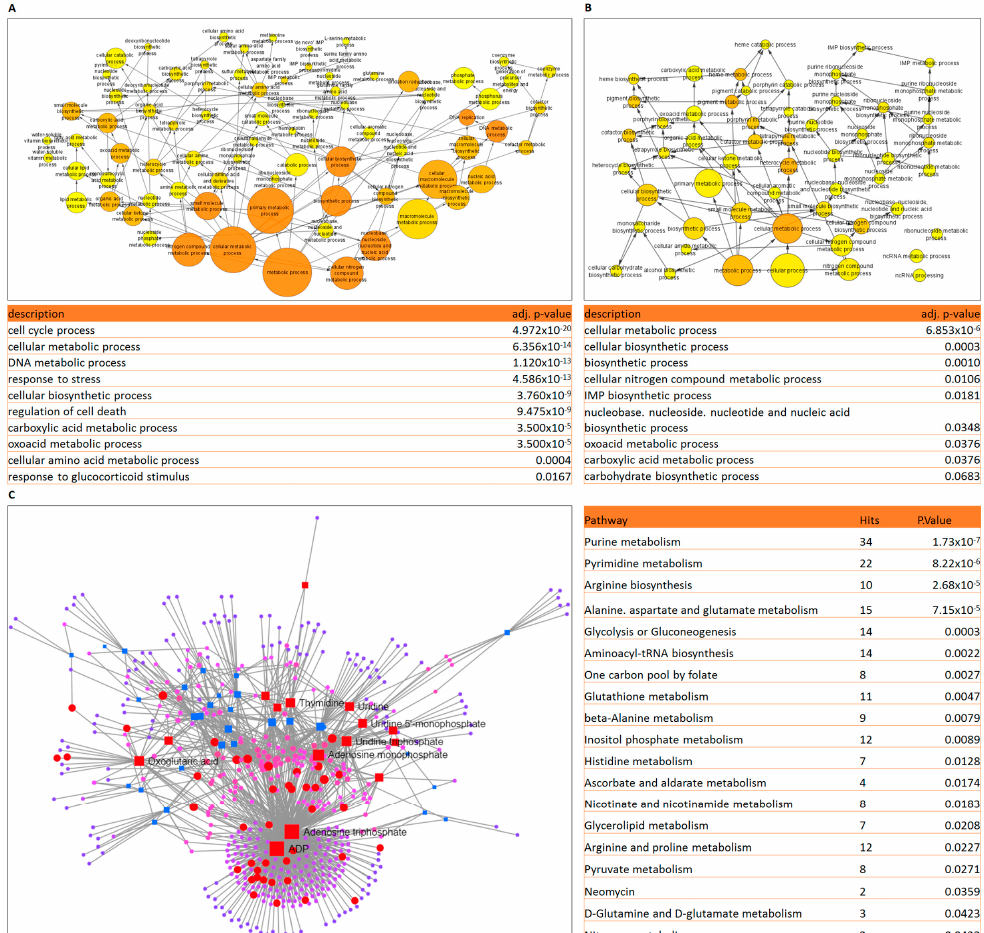
Figure 5. Gene expression analysis of metadata of matched patient samples at diagnosis and re- lapse. ( A ) GO analysis of upregulated genes in patient samples from meta-analysis [10] showing a metabolism-enriched cluster of nodes from upregulated genes in relapsed cALL patients and selected enrichment terms. ( B ) GO analysis of 142 upregulated genes found in both the meta-analysis and Sup-PR cells showing enrichment for metabolic processes, as annotated. ( C ) Integrated analysis of all up- and downregulated genes in relapse patients [10] and all dysregulated metabolites in Sup-PR cells. The genes (circles) and metabolites (squares) from the top 5 enriched KEGG terms are highlighted in red.